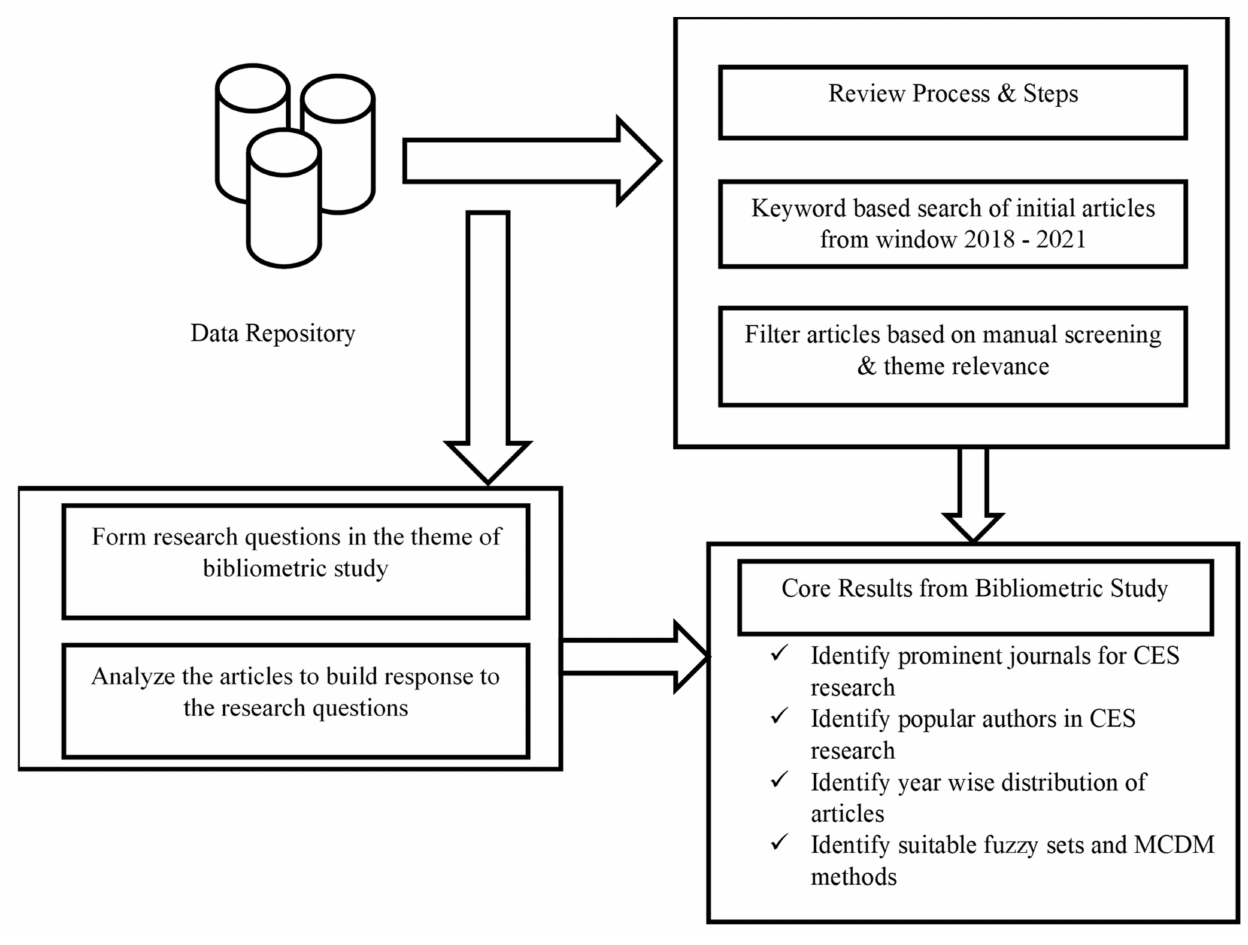
Figure 1. Overview of the review model.